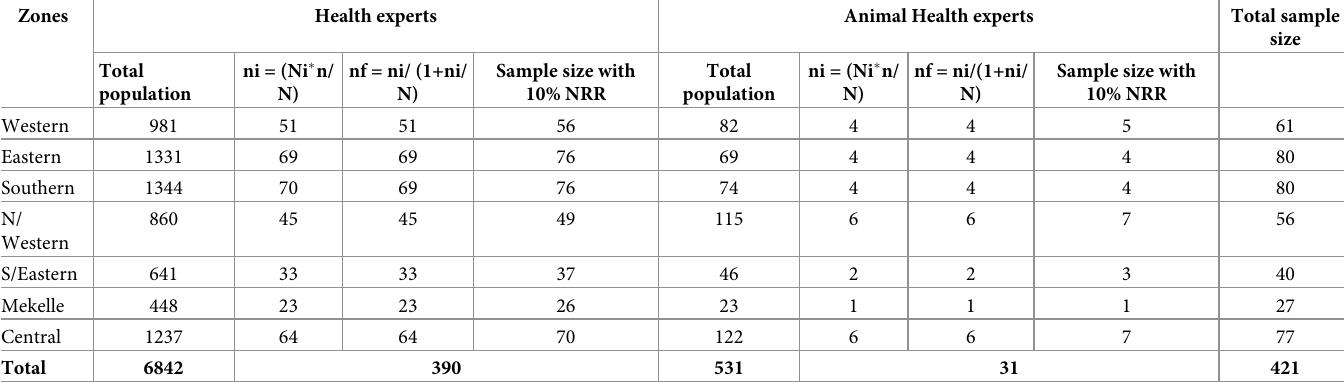
Table 1. Number of health experts by zone and sample size determination for questionnaire survey.